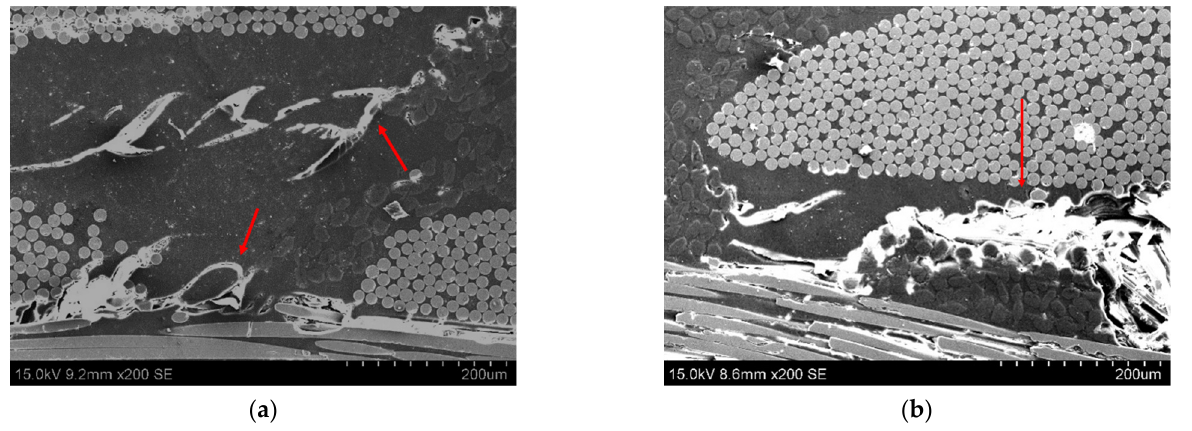
Figure 4. SEM images of transversal sections of ( a ) 15PCL-02CNT and ( b ) 15PCL-Neat. The flexural strength significantly increased with the addition of CNTs, whereas a slight decrease was observed with increasing PCL content (Figure 2b). This detriment was more prevalent in the neat samples (without CNTs), while the multiscale samples (with a 0.2 wt %) were hardly affected by increasing the PCL content. This behavior can be ex- plained by the opposite effect induced by both the CNTs and PCL. On one hand, the ad- dition of carbon nanotubes may enhance the interfacial adhesion between the matrix and the fiber, leading to a more effective load transfer, thus increasing mechanical properties [43]. On the other hand, PCL addition may negatively affect the flexural properties of the composite due to its lower mechanical performance. In this regard, a higher miscibility and better distribution of the thermoplastic phase could inhibit the detriment in the me- chanical performance due to a better combination of the blends and the glass fibers [44]. As previously mentioned, the addition of carbon nanoparticles promotes a higher misci- bility of the PCL in the epoxy matrix, which explains the decline in mechanical properties when increasing the PCL content. 3.2. Electromechanical Analysis First, the electrical conductivity in the longitudinal and transverse directions was an- alyzed. Then, the electromechanical properties under flexure and ILSS tests were also ex- plored in order to prove the SHM capabilities of the proposed materials. 3.2.1. Electrical Conductivity Measurements Figure 5 shows the electrical conductivity of the GFRP/PCL/CNT samples in the lon- gitudinal and transverse directions. The samples without carbon nanoparticles were not electrically conductive.